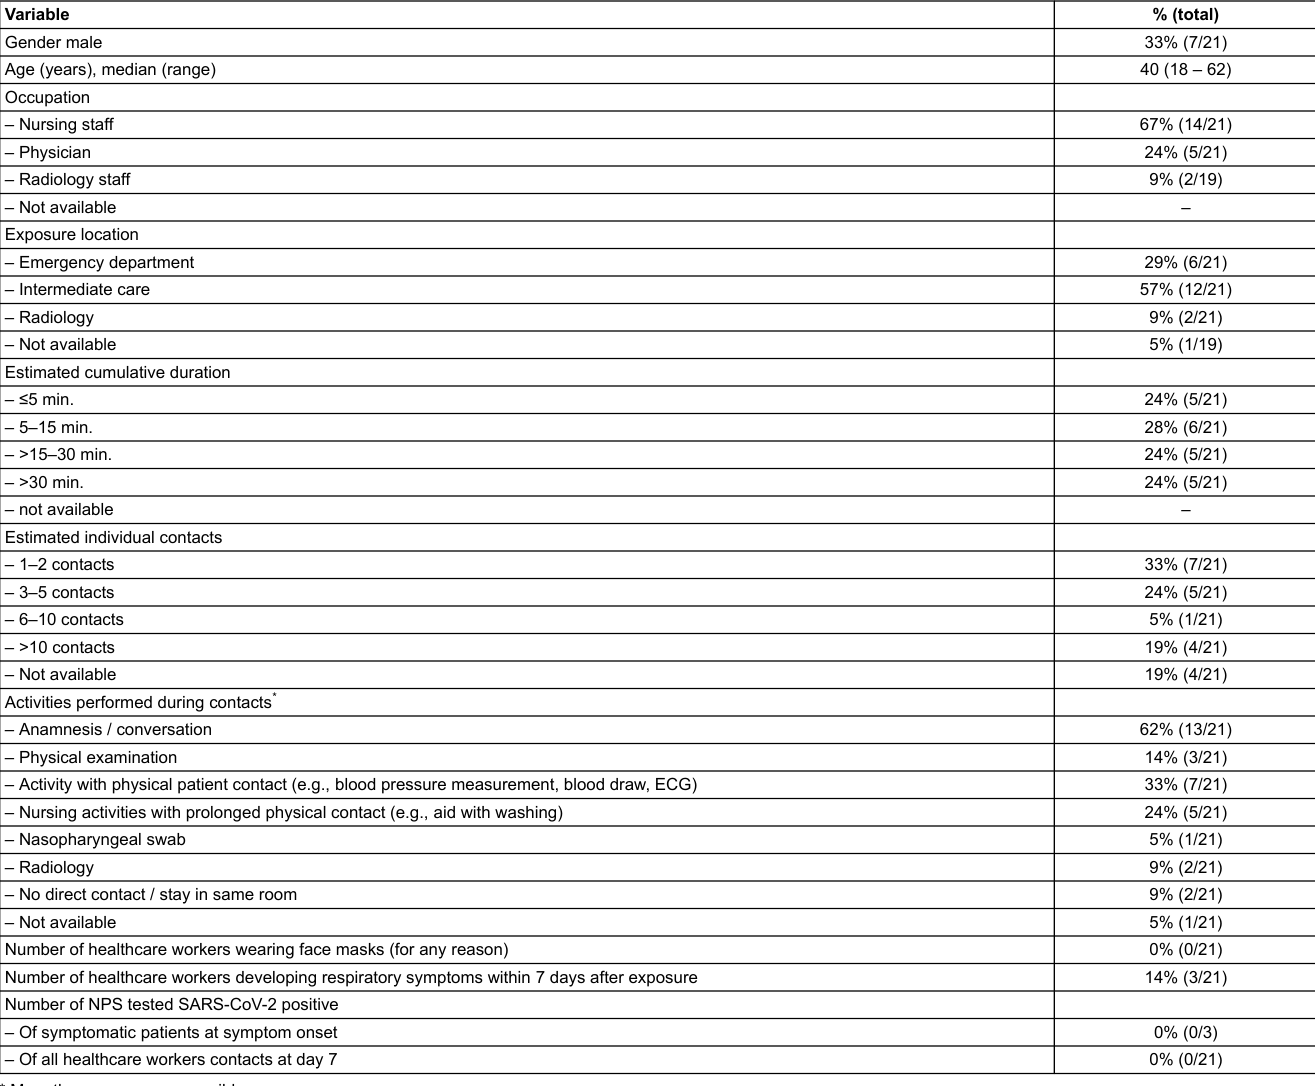
Table 1: Healthcare worker characteristics and transmission risk factors